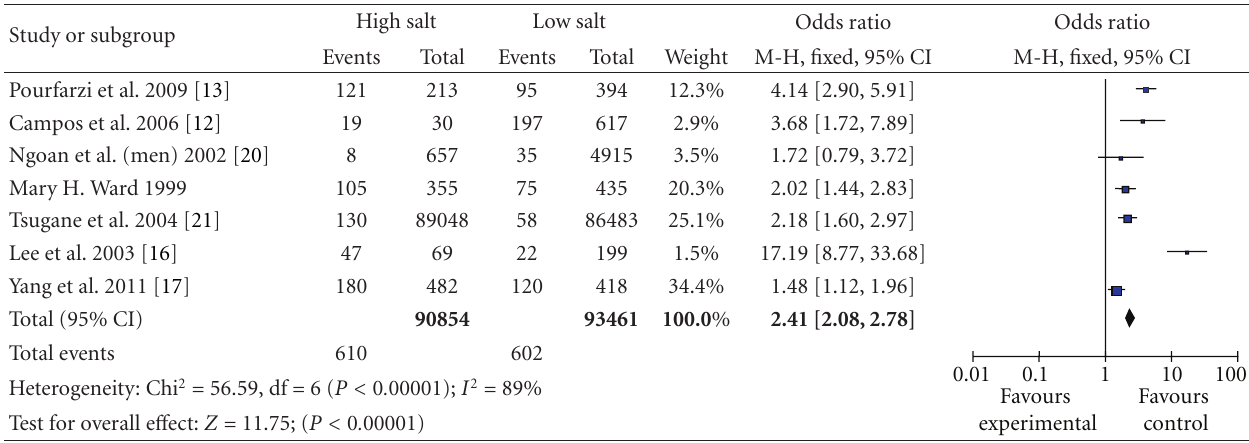
Table 8: High versus low categories of salt and gastric cancer through salty